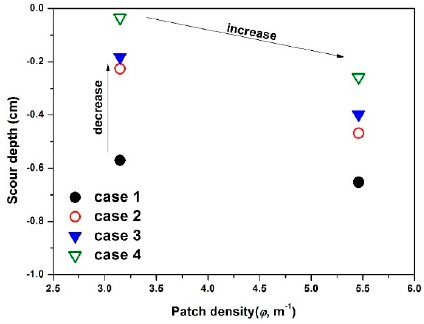
Figure 8. Maximum scour depth around the vegetation patch according to the patch density.